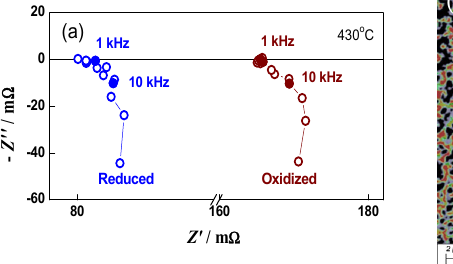
Figure 7. Bare anode cooled in oxidized state (in nitrogen) after 13 redox cycles: ( a ) impedance diagrams after the initial reduction ( • ) and after 13 redox cycles ( • ); ( b ) SEM-BSE cross section image: red—Ni; green—NiO; black—pores; grey—YSZ.